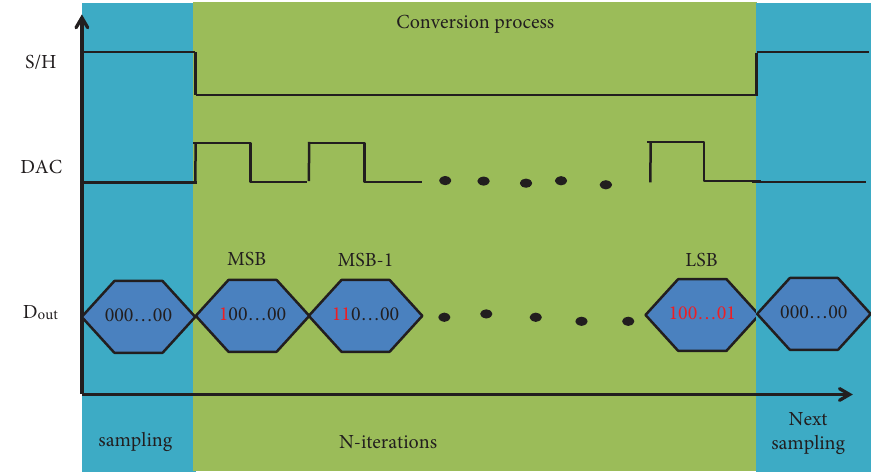
Figure 3: Clock and timing profle of the SAR